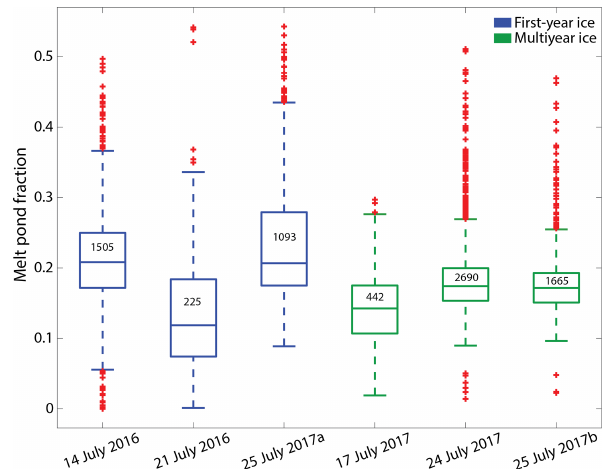
Figure 7. Melt pond statistics from summer OIB flight which con- tained only a single ice type. Blue corresponds to first-year ice statistics, green to multiyear ice statistics, and red crosses indicate outliers. The number of image frames used to calculate statistics for each flight is included inside each box. The approximate area of each image frame is 0.25km 2 .